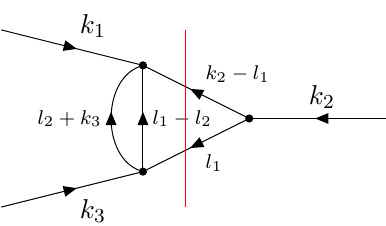
Figure 7 . One-loop s-channel diagram as a two-loop flat space three point function with k 1 = u 1 − u ζ , k 2 = u ζ , k 3 = − u 1 , l 2 = X 2 and l 1 = X 1 . The red line corresponds to the unitarity cut in the = ζ ¯ ζ k 2 2